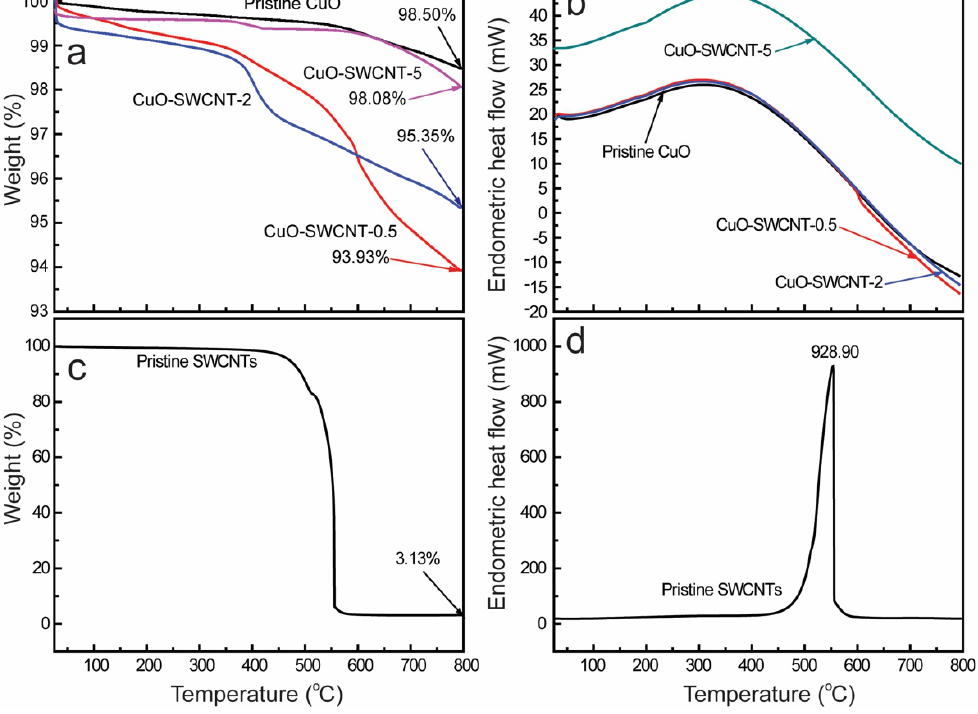
Figure 5. Thermal analysis of CuO–SWCNT nanocomposites and the pristine CuO: ( a ) Thermogravimetric analysis (TGA) plot and ( b ) Differential scanning calorimetry (DSC) plot. Thermal ( a ) Thermogravimetric analysis (TGA) plot and ( b ) Di ff erential scanning calorimetry (DSC) plot. analysis of the pristine SWCNTs: ( c ) TGA plot and ( d ) DSC plot. Thermal analysis of the pristine SWCNTs: ( c ) TGA plot and ( d ) DSC